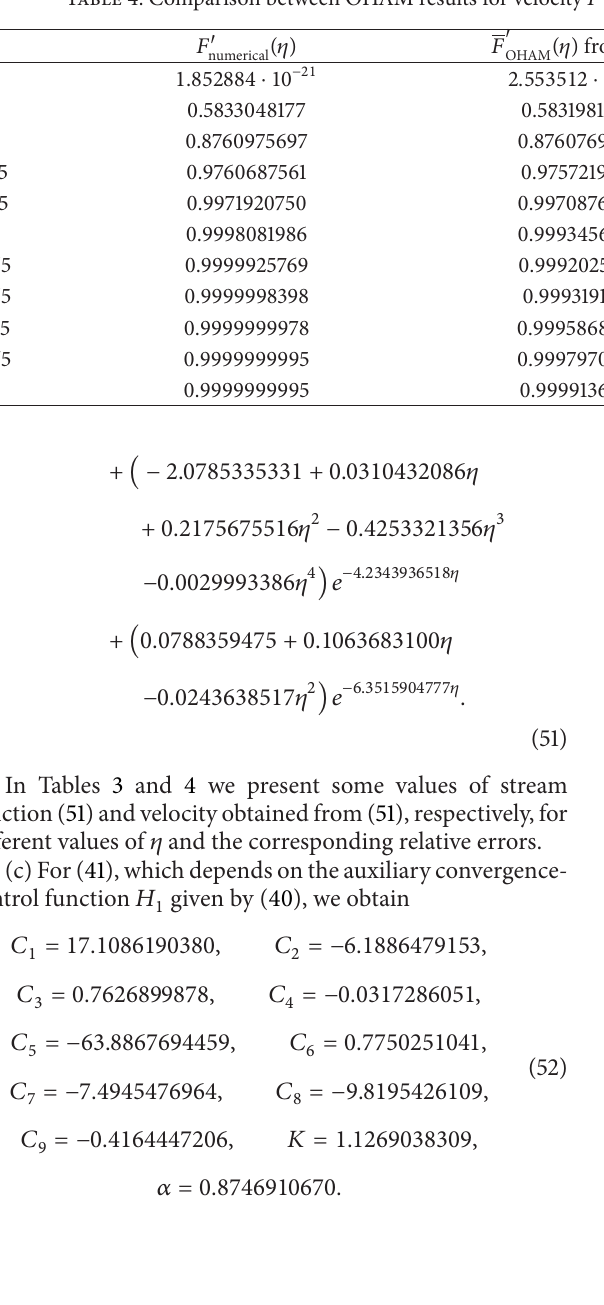
Table 4: Comparison between OHAM results for velocity 𝐹